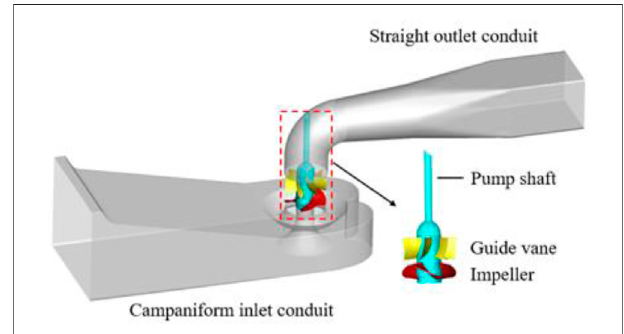
FIGURE 1 | 3D model of the vertical axial fl ow pump device.